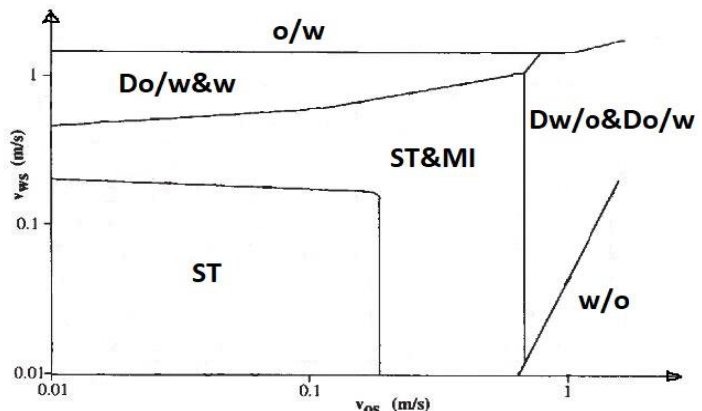
Figure 1. GraphofsuperficialwatervelocityversussuperficialoilvelocitymodifiedafterTralleroetal.[11] Figure 1. Graph of superficial water velocity versus superficial oil velocity modified after Trallero et developedfor an innerpipe diameter of 50.1mm, with µ o = 0.0288 Pas, µ w = 0.00097 Pa s, ρ o = 884 kg / m 3 , ρ w = 997 * kg / m 3 and σ = 0.036 N / m at 25.5 ◦ C. Note: for data with ( * ) , the authors recorded 1037 kg / m 3 al. [11] developed for an inner pipe diameter of 50.1 mm, with µ o = 0.0288 Pa s, µ w = 0.00097 Pa s, ρ o = for tap water at ≈ 25.5 ◦ 884 kg/m 3 , ρ w = 997 * kg/m 3 and σ = 0.036 N/m at 25.5 °C. Note: for data with ( * ) , the authors recorded 1037 kg/m 3 for tap water at ≈25.5 °C.